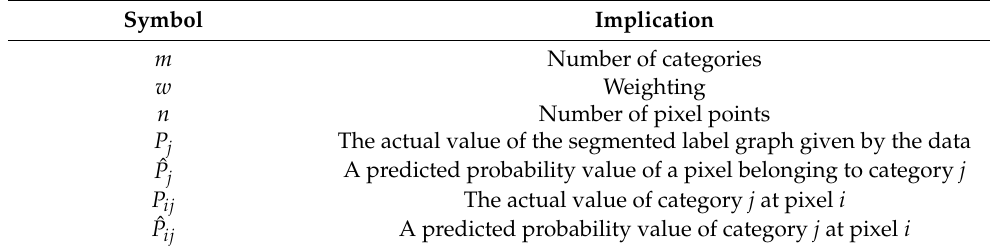
Table 2. Definition of the symbols.